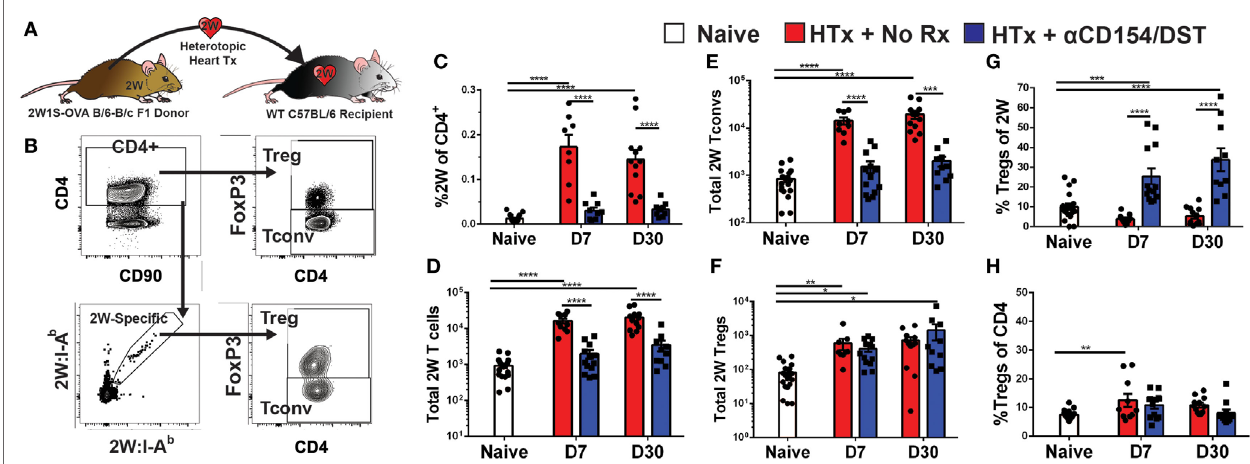
FigUre 1 | Increased donor-specific regulatory T cell (Treg) percentages in the spleens of costimulatory blockade-induced tolerant recipients is due to inhibition of conventional T cell (Tconv) expansion and modest accumulation of Tregs. C57BL/6 recipients were transplanted with heterotopic heart allografts from Act.2W-OVA + BALB/c × C57BL/6 F1 donors. Recipients were either given anti-CD154 on days 0, 7, and 14 post-transplantation plus donor splenocyte infusion on day 0 ( α CD154/DST), or were untreated (No Rx). On day 7 or day 30 post-transplantation, mice were sacrificed and their splenocytes were analyzed. (a) Cartoon depicting the experimental protocol. (B) Sample gating strategy of CD4 + splenocytes for 2W:I-A b (2W) Tregs. (c) Percentage 2W-specific cells among CD4 + T cells. (D) Total number of 2W-specific CD4 + T cells in the spleen. (e) Total number of 2W-specific FoxP3 – CD4 + Tconv in the spleen. (F) Total number of 2W-specific FoxP3 + CD4 + Tregs in the spleen. (g) Percentage of FoxP3 + Tregs among 2W-specific CD4 + T cells. (h) Percentage of FoxP3 + Tregs among all splenic CD4 + T cells. ** p < 0.01, *** p < 0.001, **** p < 0.0001 by one-way ANOVA when comparing between naïve and individual time points and by two-tailed t -test when comparing between treatment groups. Mean ± SEM is shown, and each point represents one animal from 4–5 replicate experiments per time point ( n =